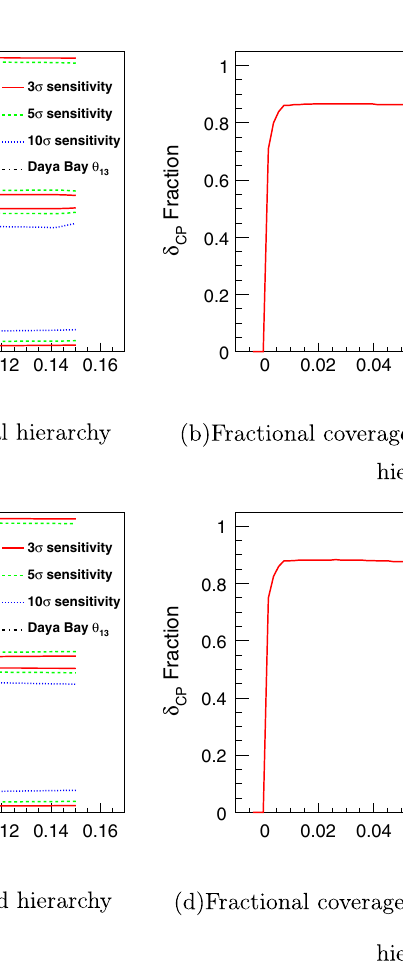
FIG. 13. Sensitivity of a MIND at a neutrino factory to the discovery of CP violation assuming both a normal and inverted mass measured by Daya Bay is shown with the black dotted line superimposed on the coverage hierarchy as noted. The range of sin 2 2 (cid:1) 13 contours and the fractional 5 (cid:7)